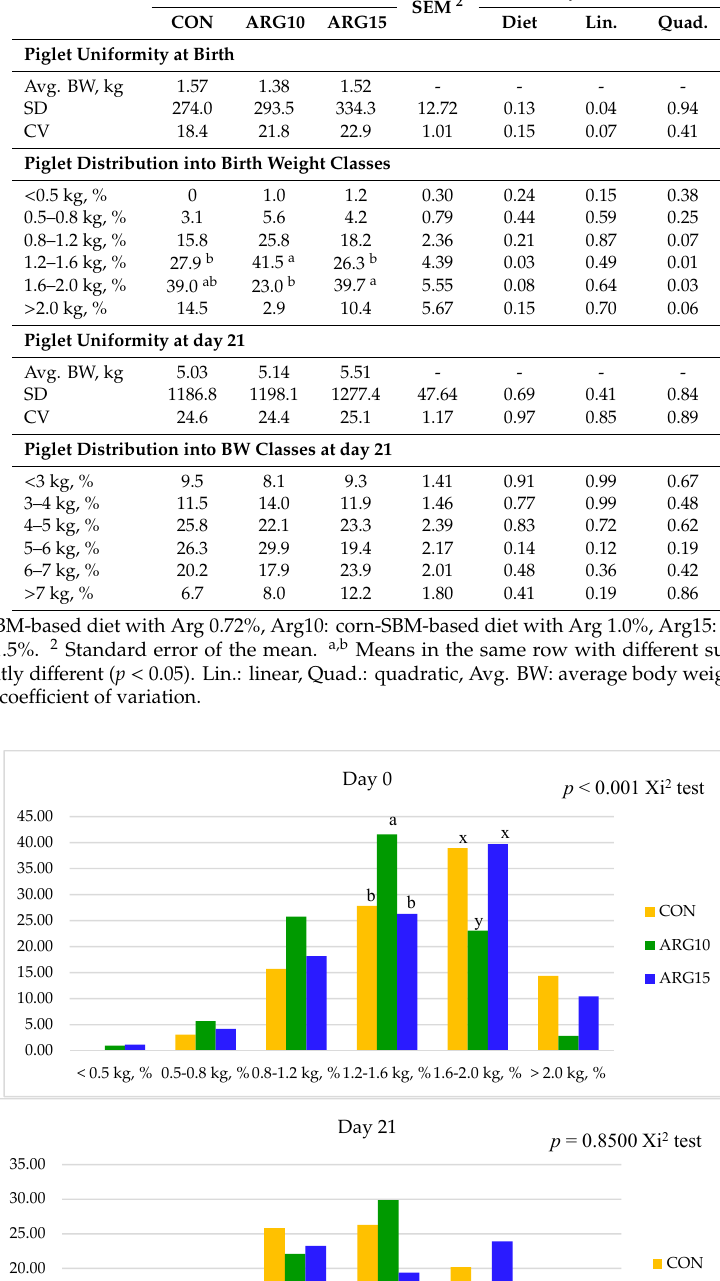
Table 5. E ff ects of arginine supplementation levels on piglet uniformity in late-gestating sows. p -Value Treatment 1 SEM 2 CON ARG10 ARG15 Diet Lin. Quad.